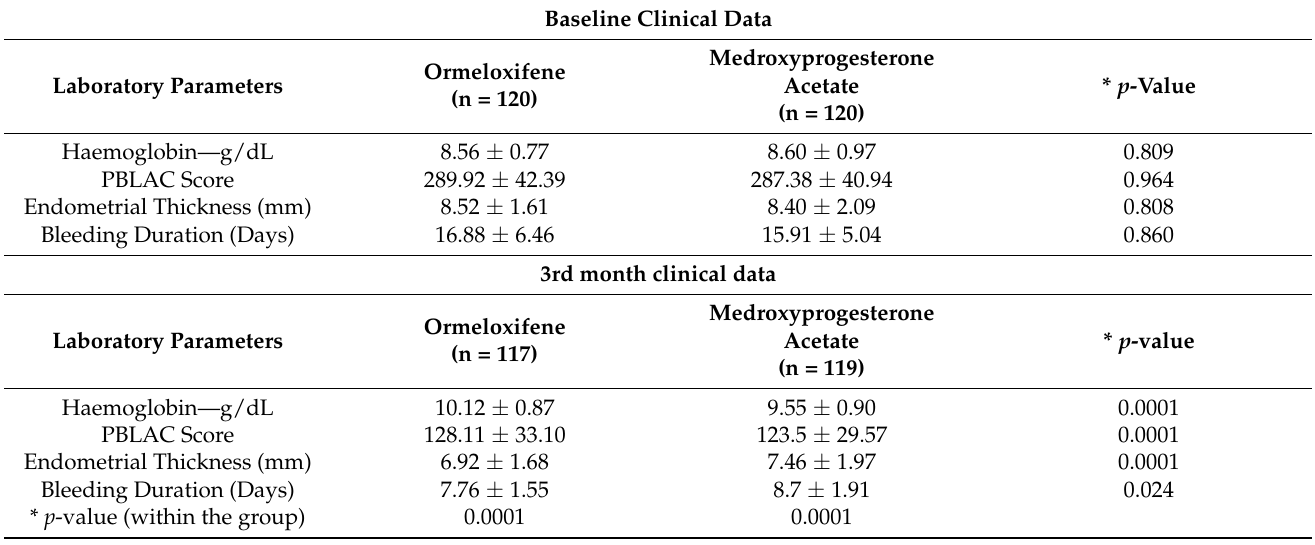
Table 3. Baseline and 3rd month clinical data of ormeloxifene and medroxyprogesterone acetate.